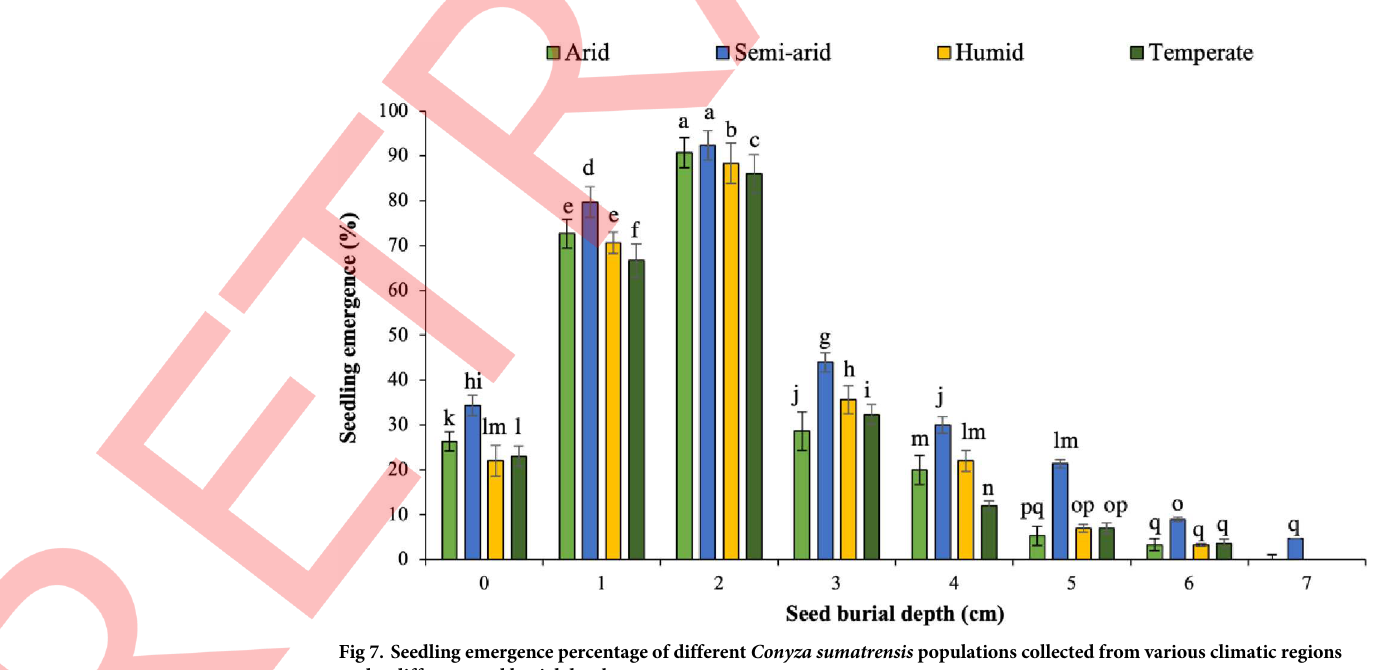
Fig 7. Seedling emergence percentage of different Conyza sumatrensis populations collected from various climatic regions under different seed burial depths.